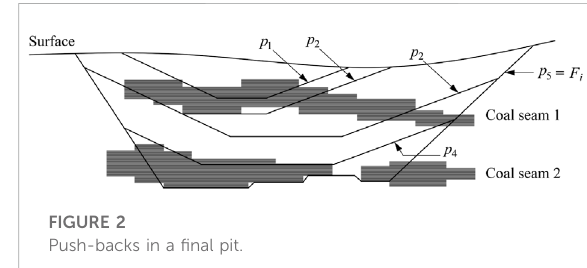
FIGURE 2 Push-backs in a fi nal